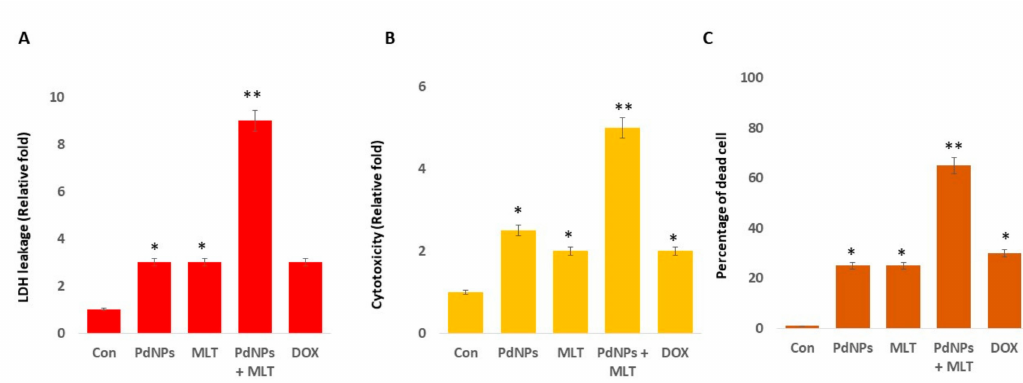
Figure 4. E ff ects of PdNPs + MLT in A549 cells. ( A ) LDH leakage, ( B ) cytotoxicity, and ( C ) percentage of dead cells in each of the following treatments: control, 2.5 µ M PdNPs, 0.75 mM MLT, 2.5 µ M PdNPs combined with 0.75 mM MLT, and 5 µ M DOX. Results are shown as the mean ± standard deviation of three independent experiments. The treated groups showed statistically significant di ff erences from the control group per Student’s t -test. * p < 0.05 was considered significant; ** p < 0.01 was considered highly